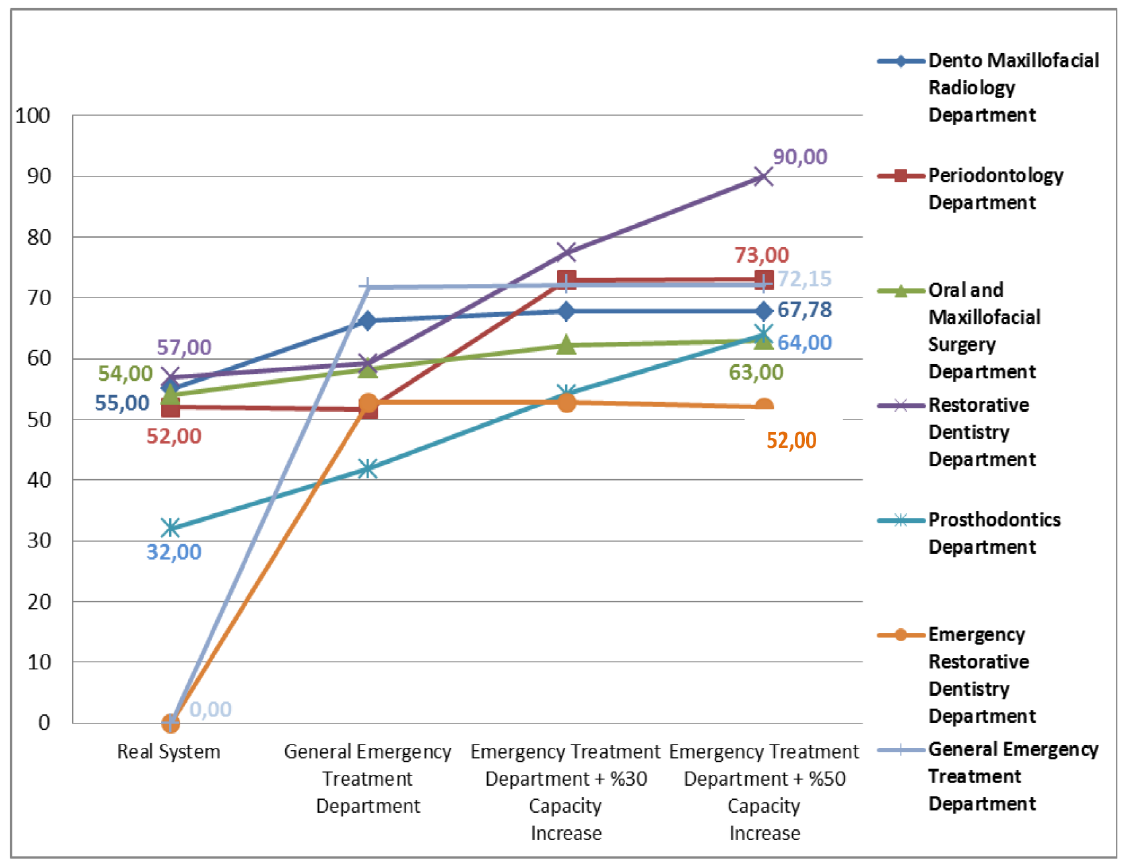
Figure 9. The enhancement of dentists utilization rates for new proposed